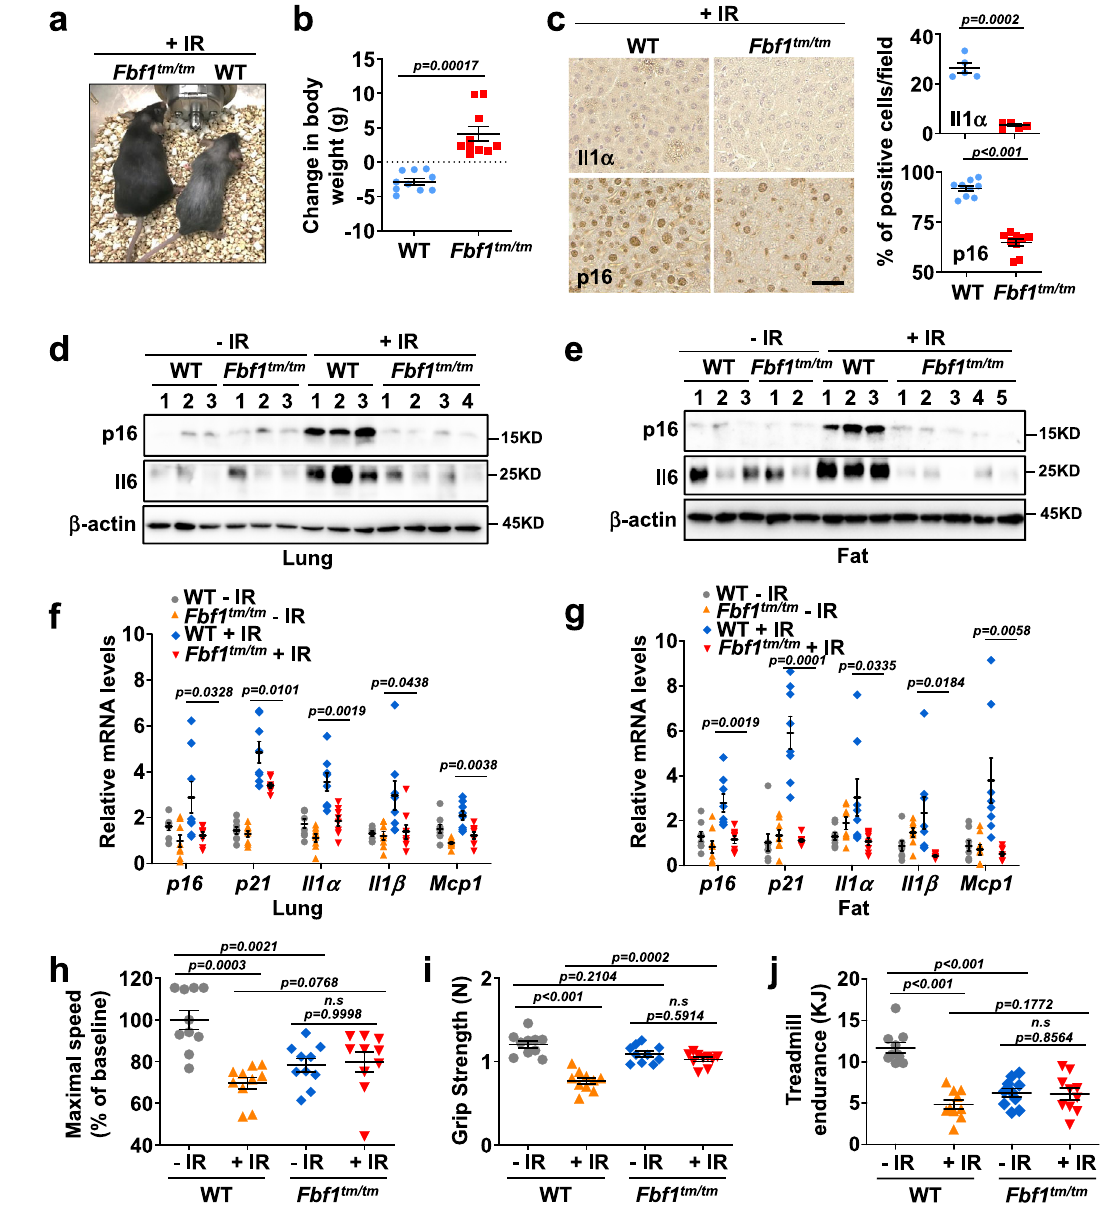
Fig. 6 | Fbf1 ablationprotectsmicefromIR-induced senescenceandassociated frailty. a Representative images of mice 3 months after IR. b The change in body weight of mice with 3 months after IR. n =10 mice. c at 2 weeks after IR, liver was analyzed by immunohistochemistry using Il1 α antibody or p16 antibody and quanti fi ed; Scale bar: 200 µ m. n >80 cells were counted in n =5 different fi elds in n =3 mice ’ s Il1 α staining and n =8 different fi elds in n =4 mice ’ s p16 staining d , e Lysatesobtainedfromlung( d )andfat( e )tissueofWTmice,or Fbf1 tm1a/tm1a mice 2weeksafterIRwereanalyzedfortheindicatedproteinsbywesternblot. f , g SASP- related genes were assessed by RT-qPCR in extracts of lung ( f ) and fat ( g ) tissue of